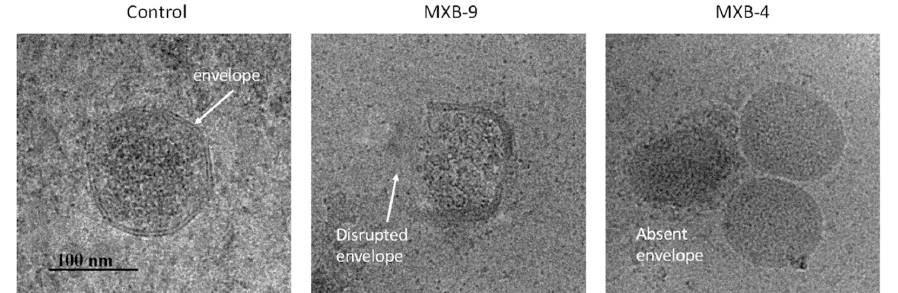
Figure 5. Cryo-EM imaging of peptoid-treated SARS-CoV-2. Virus was treated for 2 h at 37 °C followed by preparation for EM imaging as described in Materials and Methods. Visible are par- tially disrupted membrane (center) and completely absent membrane (right panel, next to two unaffected virions).